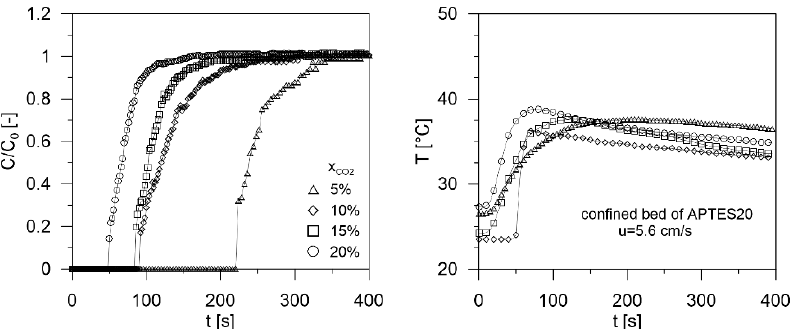
Figure 9. Breakthrough curves and corresponding temperature at different CO 2 concentrations for APTES20 in conventional fixed bed at u = 5.6 cm/s.